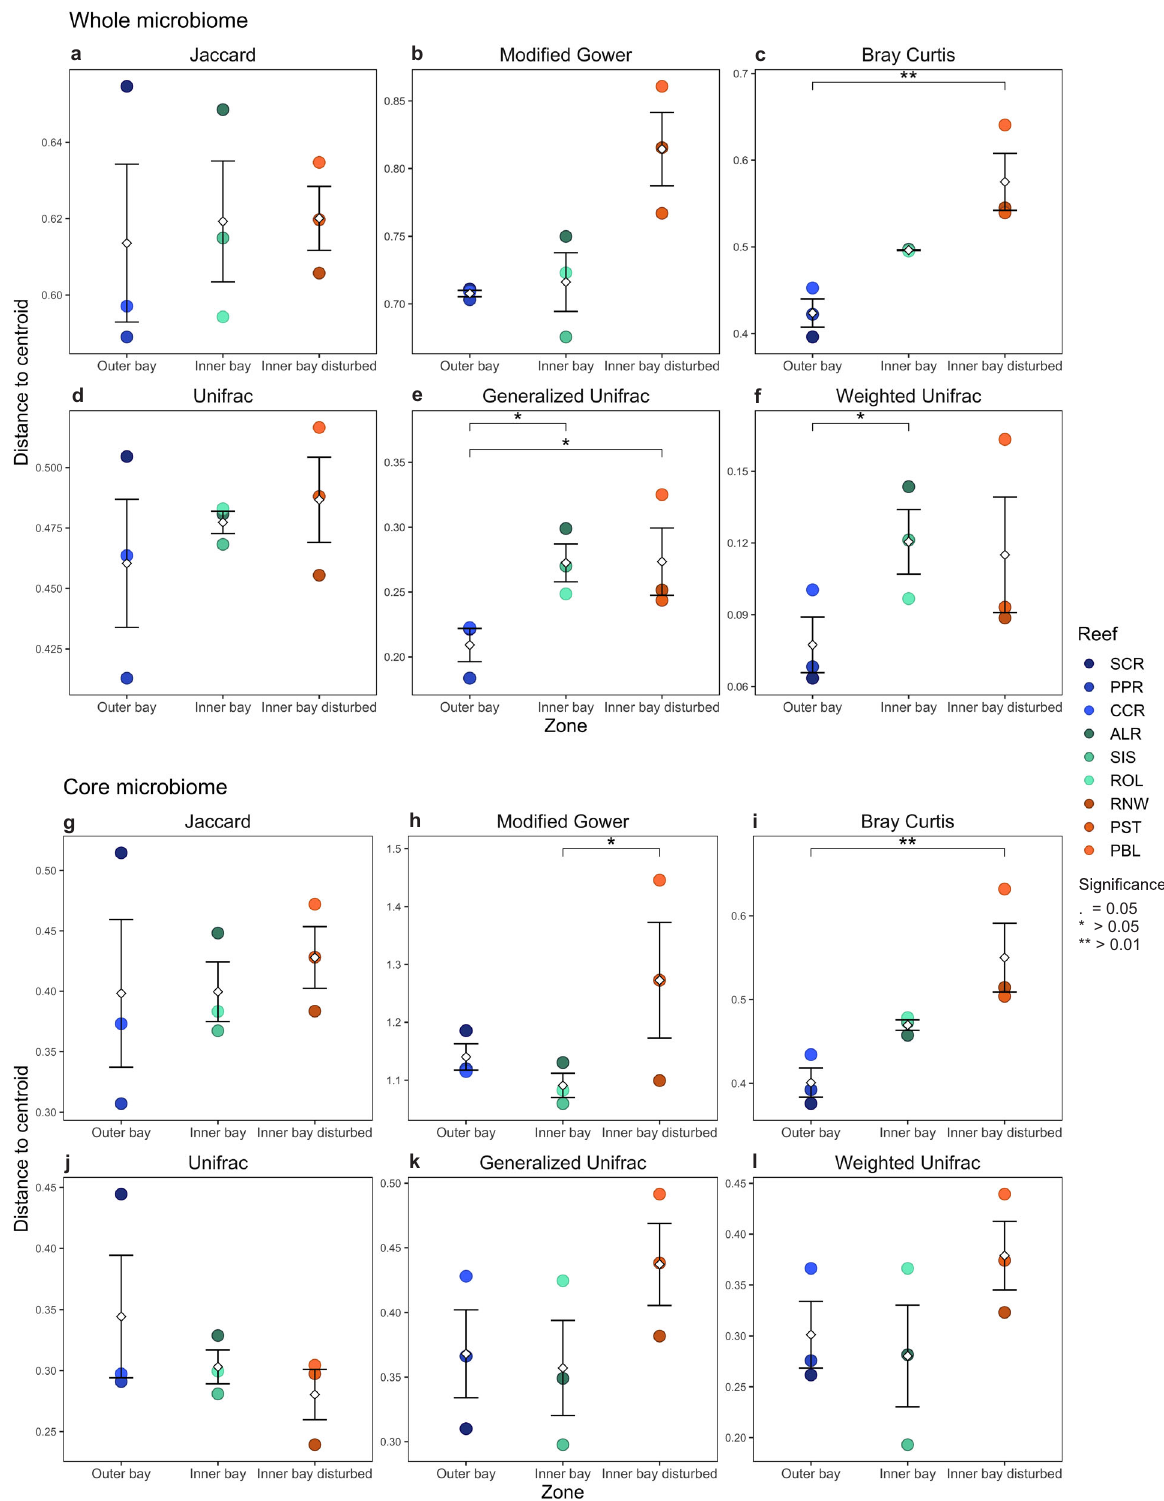
Fig. 4 Multivariate dispersion. Compositional variability of the whole gut microbiome ( a – f ) and core gut microbiome ( g – l ) of Chaetodon capistratus across reefs. Compositional variability is measured as the distance to the centroid (mean ± SE) of each group ( fi sh at each reef) in multivariate space. Multivariate analyses were computed with non-phylogenetic (Jaccard: panels a , g ; Modi fi ed Gower: panels b , h ; and Bray – Curtis: panels c , i ) and phylogenetic (Unifrac: panels d , j ; Generalized Unifrac: e , k ; Weighted Unifrac f , l ) metrics that differ in how much weight they give to relative abundances. On one end of the spectrum, Jaccard and Unifrac only use presence-absence data, whereas on the other end of the spectrum Bray – Curtis and Weighted Unifrac give a lot of weight to abundant ASVs in dissimilarity calculations. Signi fi cance depicts differences in multivariate dispersion between reef zones (ANOVA). Diamonds depict